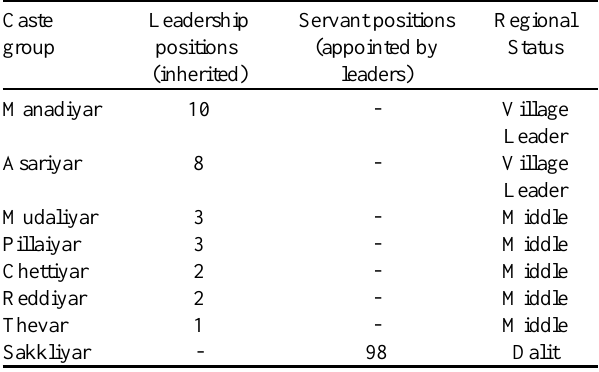
Table 1. Caste-wise distribution of traditional village leadership and servant positions in six study villages. The Sakkliyar are the predominant servant caste in the Palani hills region. See appendix for further detail on traditional